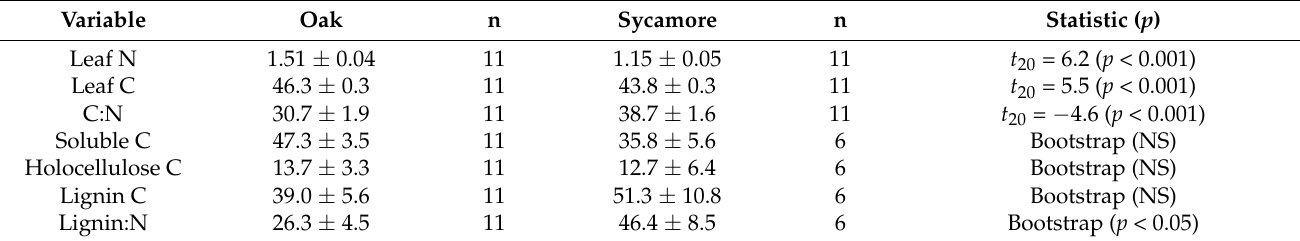
Table 1. Mean ( ± se) initial leaf carbon and nitrogen chemistry for the oak and sycamore leaves used in the decomposition experiment. Shown also are the results of a 2-sample t -test (with degrees of freedom) and a bootstrap randomization test, which were used because of unequal sample sizes (n). All values except the leaf C:N ratio are in percentages. NS = not statistically significant ( p >